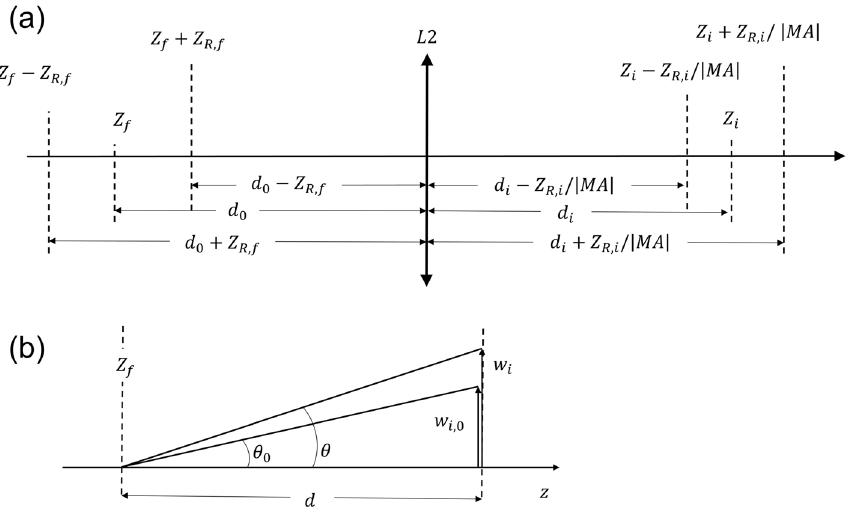
Figure 6. Conceptual diagrams used for calculation of the beam size at the imaging (far-field) planes. (a) Τhe correspondence of focal and imaging planes so that the linear magnification of the system MA remains invariant. (b) A diagram that shows how the beam size w i,0 at a distance d in the far-field shifts to w i when accounting for the power dependence of the divergence